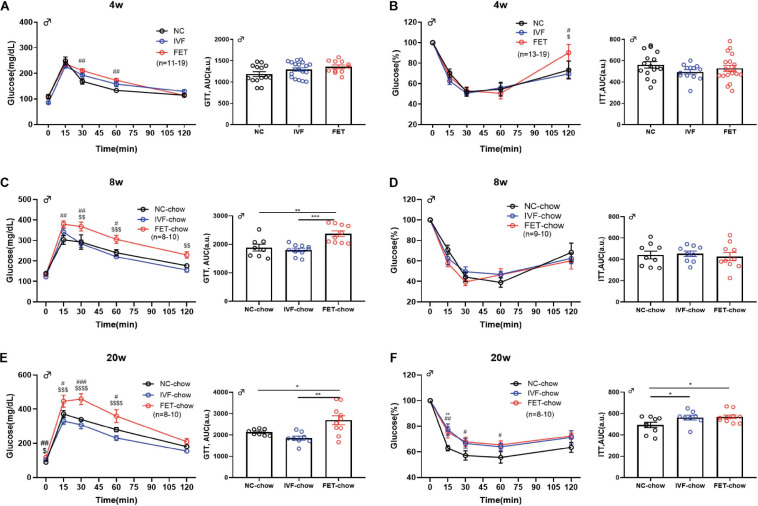
GTT and ITT in chow-fed male offspring. (A) Glucose tolerance test and AUC in 4-week-old chow-fed male offspring (nNC–chow = 14, nIVF–chow = 19, and nFET–chow = 11). (B) Insulin tolerance test and AUC in 4-week-old chow-fed male chow offspring (nNC–chow = 16, nIVF–chow = 13, and nFET–chow = 19). (C) Glucose tolerance test and AUC in 8-week-old chow-fed male offspring (nNC–chow = 8, nIVF–chow = 10, and nFET–chow = 10). (D) Insulin tolerance test and AUC in 8-week-old chow-fed male offspring (nNC–chow = 9, nIVF–chow = 9, and nFET–chow = 10). (E) Glucose tolerance test and AUC in 20-week-old chow-fed male offspring (nNC–chow = 8, nIVF–chow = 8, and nFET–chow = 10). (F) Insulin tolerance test and AUC in 20-week-old chow-fed male offspring (nNC–chow = 9, nIVF–chow = 8, and nFET–chow = 10). All data were expressed as the mean ± SEM. **P < 0.01 IVF-chow vs NC-chow; #P < 0.05 FET-chow vs NC-chow; ##P < 0.01 FET-chow vs NC-chow; ###P < 0.001 FET-chow vs NC-chow; $P < 0.05 FET-chow vs IVF-chow; $$P < 0.01 FET-chow vs IVF-chow; and $$$P < 0.001 FET-chow vs IVF-chow (ANOVA).